Question: Sum up the contents of this chart in one sentence.
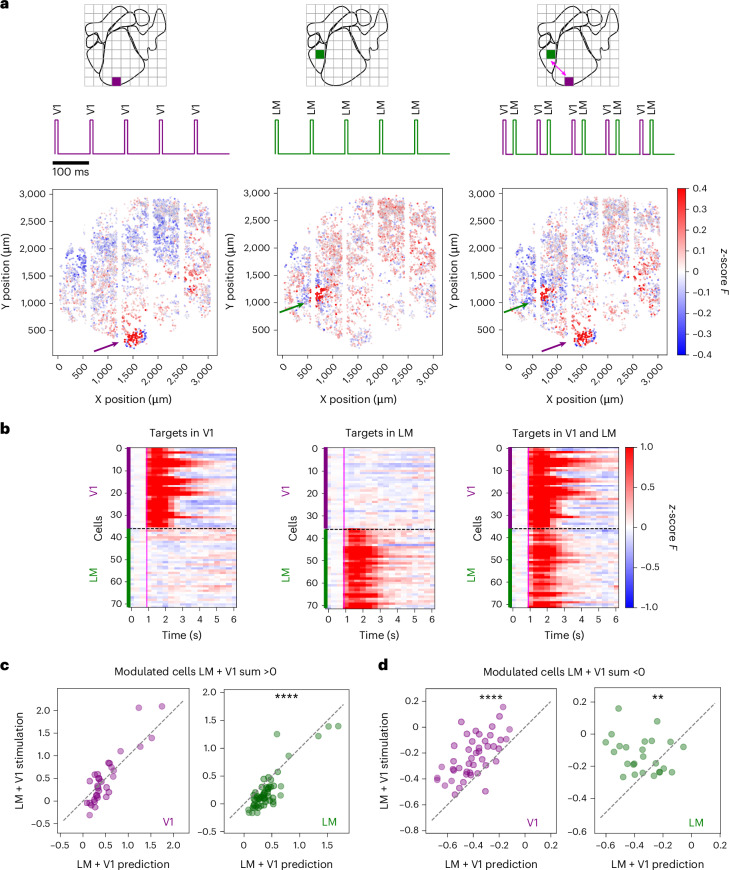
Answer: Rapidly interleaved photostimulation of distant neural ensembles. a , Top, principle of rapidly interleaved photostimulation on the mesoscope with hologram interleaving: 10 Hz pulsed stimulation in V1 with hologram 1 (left), 10 Hz pulsed stimulation in LM with hologram 2 (center) and fast interleaved 10 Hz hologram 1 and hologram 2 stimulation (right) at 52.6 Hz galvanometer interleaving rate (that is, 19 ms between end of stimulation pulse for hologram 1 and start of stimulation pulse for hologram 2). Bottom, mesoscopic influence maps for single-hologram perturbation in V1 (left), single-hologram perturbation in LM (center) and joint interleaved holograms in V1 and LM (right). All cells detected in the FOV are displayed with a color displaying their relative response to photostimulation. Arrows indicate holographic perturbations. In total, 35 cells were photostimulated in LM and 35 cells were photostimulated in V1. b , Average post-stimulus calcium responses when stimulating one single neural ensemble in V1 (left), one single neural ensemble in LM (center) and both co-activated neural ensembles (right). Experiment performed on a mesoscopic 3.1 mm × 3.1 mm FOV recorded at 3 Hz, in a CaMK2 -tTA; tetO-GCaMP6s transgenic mouse injected locally with viral pAAV-hSyn-GCaMP6m-p2A-ChRmine-Kv2.1-WPRE at discrete locations. Photostimulation with ten pulses (10 ms,10 Hz, 12.5 mW). c , d , Scatter plots showing for every modulated cell by V1 perturbation (purple) or LM perturbation (green), the calcium response to the joint V1 + LM holographic photostimulation against the predicted calcium response computed from summing responses to single V1 stimulation and LM stimulation. Given the non-normality of the distribution, responses are split depending on whether the predicted sum V1 + LM is positive ( c ) or negative ( d ). n = 2 mice, three sessions. In c , the left panel shows n = 32 modulated cells from V1 stimulation, fraction of sublinear cells 0.59, P = 0.50 (two-sided Wilcox